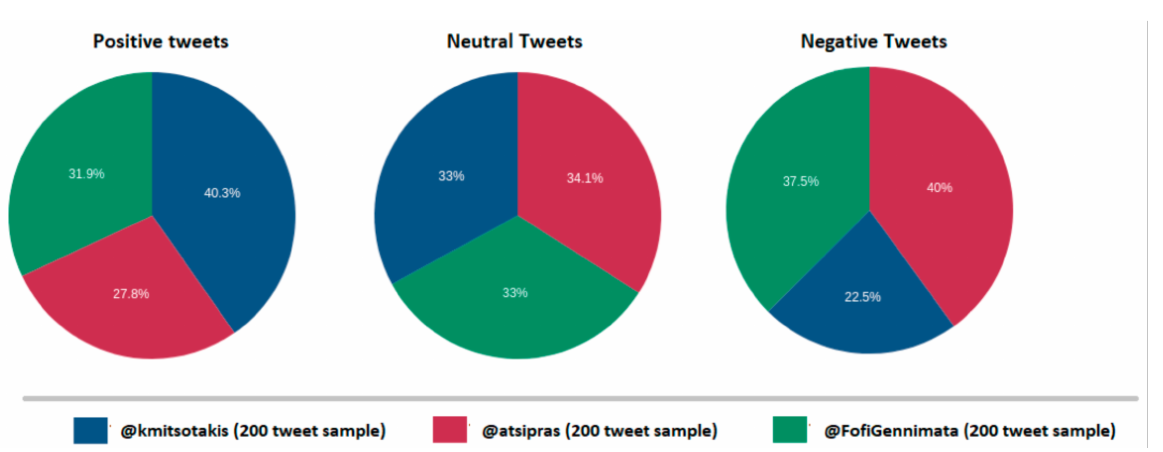
Figure 26. Sentiment Analysis comparison for all political leaders—600 tweet sample; 200 for each one of them (@primem- inisterGR is